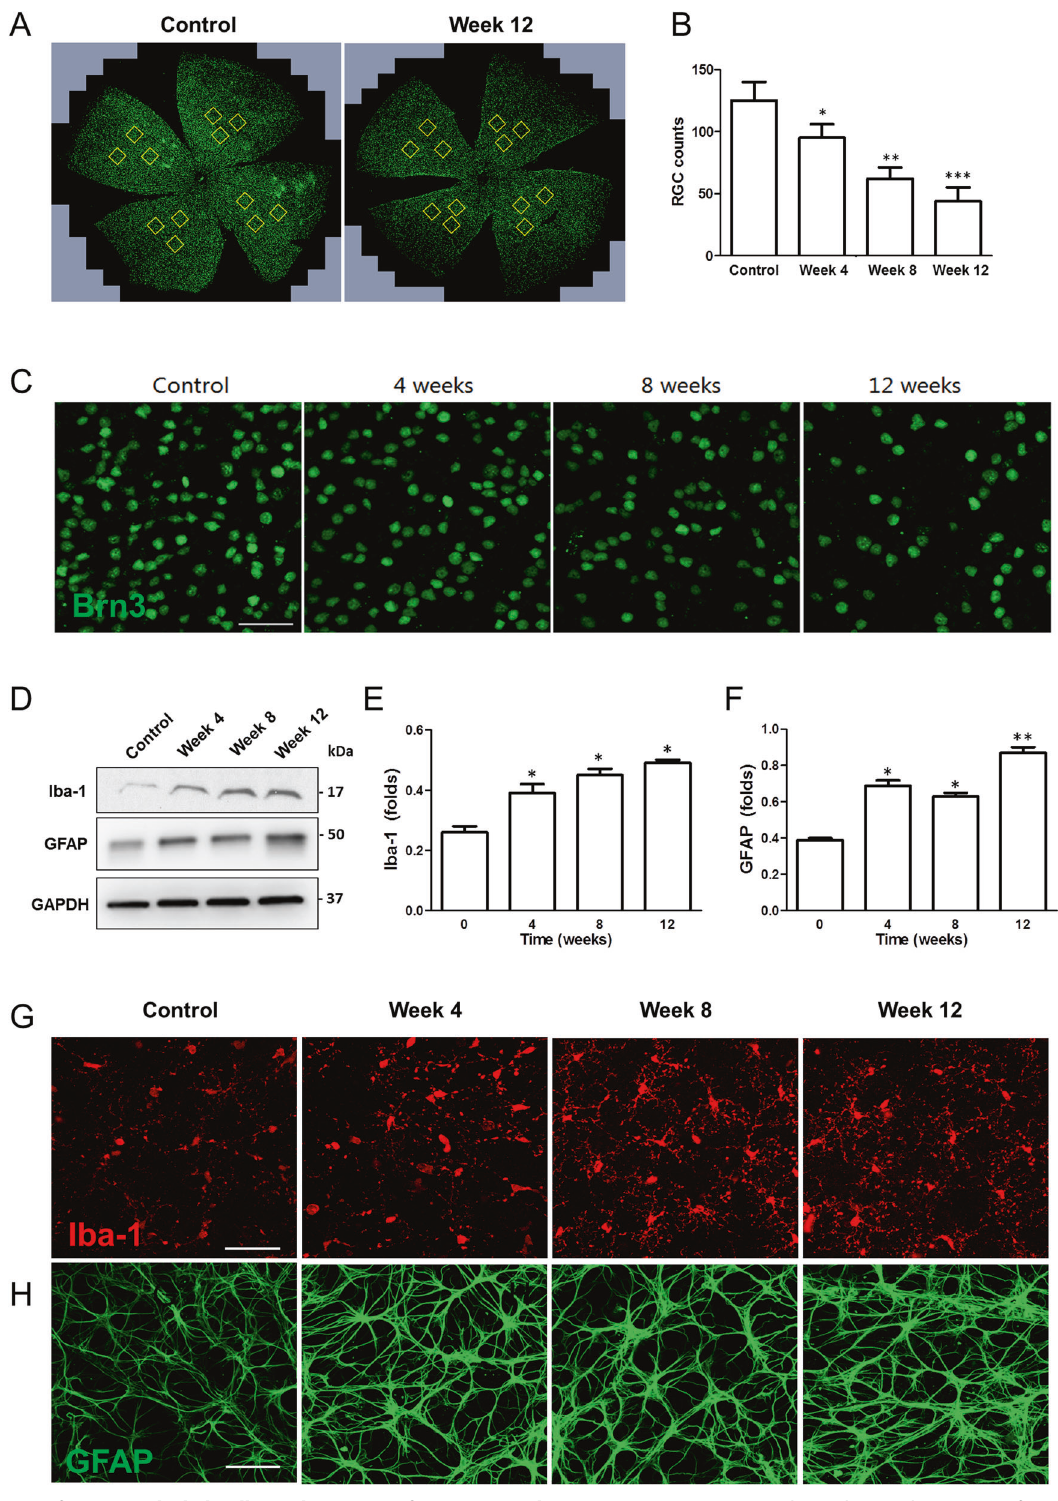
Fig. 2 Changes of RGCs and glial cells in the retina after systemic hypotension. A – C Immunohistochemical staining of Brn3a from fl at- mounted retina. Signi fi cant and gradual decrease of RGC number was revealed. For immunohistochemical staining, n = 6 for control and n = 6 for systemic hypotension at each time period; total n = 24. Bar represents mean ± SD. Student ’ s t -test was used for statistical evaluation. * P < 0.05 compared to the control. D – F Western blot and quanti fi cation of the blots. G , H immunohistochemical staining of Iba-1 and GFAP. Iba-1 and GFAP expression was increased in systemic hypotensive rats. GAPDH was used as an endogenous control in western blot analyses. Scale bars: 50 μ m. For western blot analysis, n = 6 for control and n = 6 for systemic hypotension at each time period; total n = 48. Bar represents mean ± SD. Student ’ s t -test was used for statistical evaluation. * P < 0.05, ** P < 0.01, and *** P < 0.001 compared to the